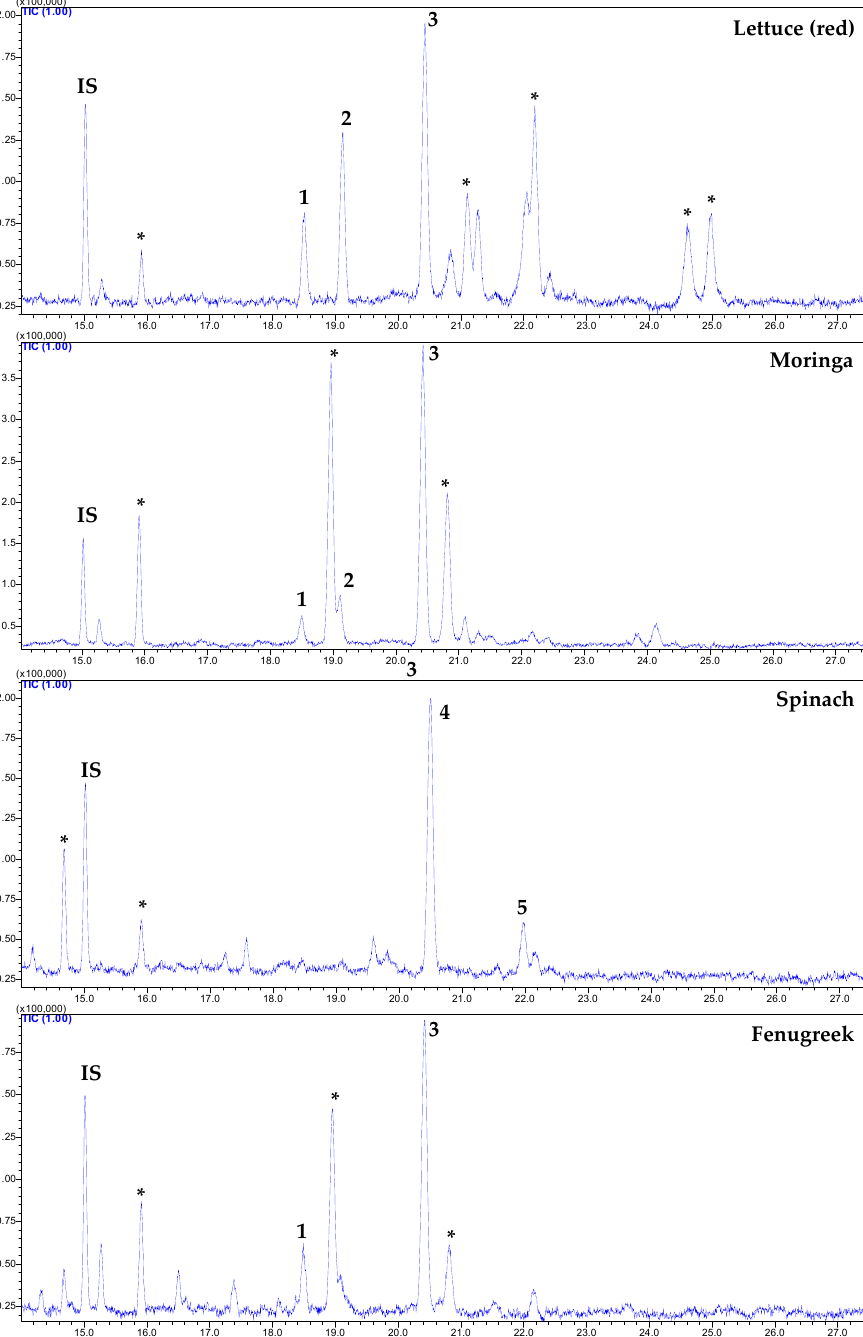
Figure 2. The characteristic GC-MS-total ion chromatograms of phytosterols identified in studied GLVs. IS: internal standard. 1, campesterol; 2, stigmasterol; 3, β -sitosterol; 4, α -spinasterol; and 5, 22, 23-dihydrospinasterol. * not a sterol compound.